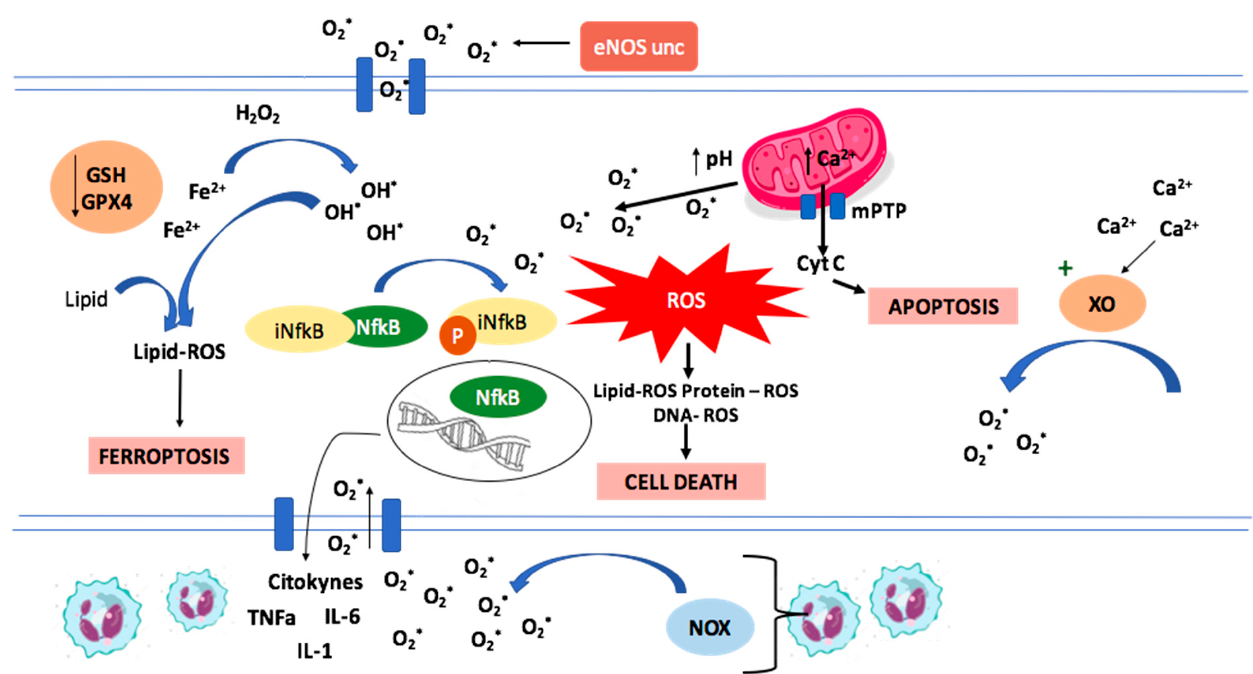
Figure 1. Representation of mechanisms involved in Ischemia/Reperfusion damage. The increase in intracellular calcium concentration is related to the activation of xanthine oxidase, a pro-oxidant enzyme. The increase in intramitochondrial calcium and the pH increase during reperfusion lead to the opening of mPTP and the loss of mitochondrial transmembrane potential, associated with ROS production. Reactive oxygen species activate the NF κ B transcription factor, promoting inflammation and neutrophil migration to the injury zone and increasing ROS production by NADPH oxidase. Another ROS source is the uncoupled eNOS. Reactive oxygen species peroxidize lipids, proteins, and DNA, triggering cell death, together with apoptosis that happens from the release of cytochrome c through mPTP and ferroptosis that occurs in the context of a decrease in GSH and GPX4 activity, with accumulation of lipid peroxidation products.